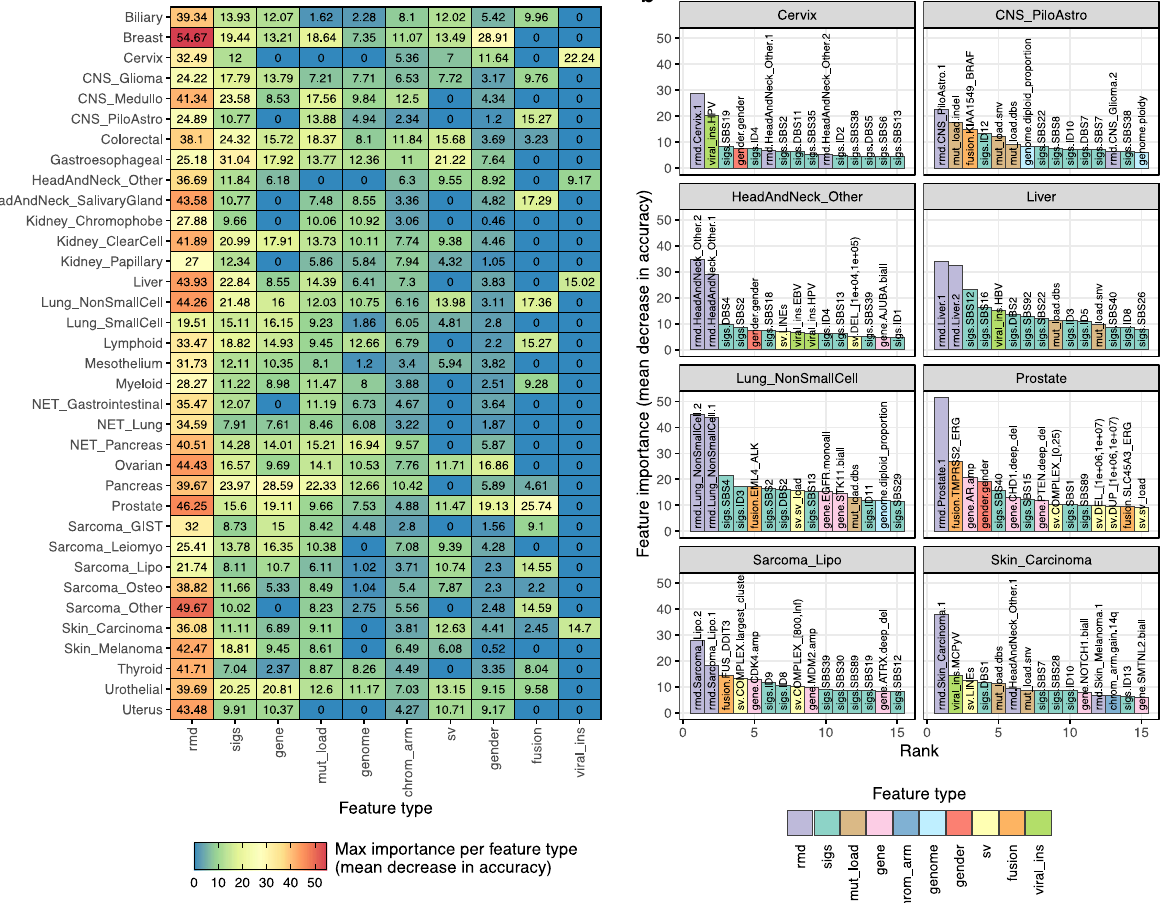
Fig. 3 Features most predictive of cancer type. a Maximum feature importance per feature type for each cancer type random forest from CUPLR. See Supplementary data 3 for the descriptions as well as feature importance values for each feature. b Feature importances from the top 15 features for selected cancer type random forests. Feature names are in the form {feature type}.{feature name}. Feature type abbreviations: rmd regional mutation density pro fi les, sigs mutational signatures, mut_load total number of single base substitutions, double base substitutions or indels, gene presence of gene gain or loss of function events, chrom_arm chromosome arm copy number fold change versus overall genome ploidy, genome genome properties including genome ploidy, diploid proportion, whole-genome duplication status, gender sample gender as determined by copy number data, sv structural variants, fusion presence of gene fusions, viral_ins presence of viral sequence insertions. Cancer type abbreviations, CNS central nervous system,